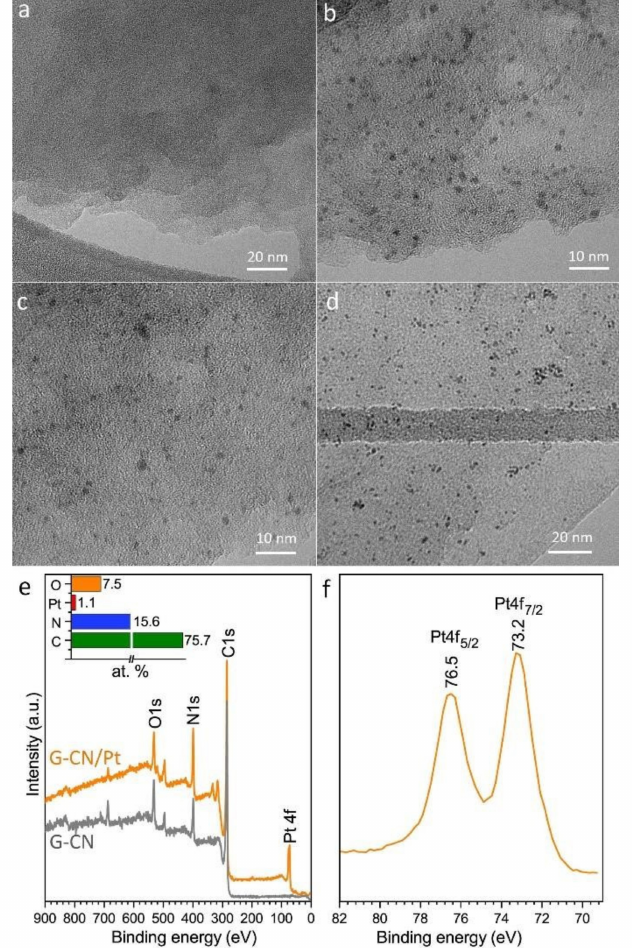
Figure 1. Transmission electron microscopy of ( a ) the starting cyanographene (G-CN) and ( b – d ) after the formation and immobilization of Pt nanoparticles (G-CN / Pt). ( e ) X-ray photoelectron spectroscopy survey spectra of G-CN and G-CN / Pt. The inset shows the atomic composition of G-CN / Pt. ( f ) HR-XPS of the G-CN / Pt sample, showing the Pt 4f